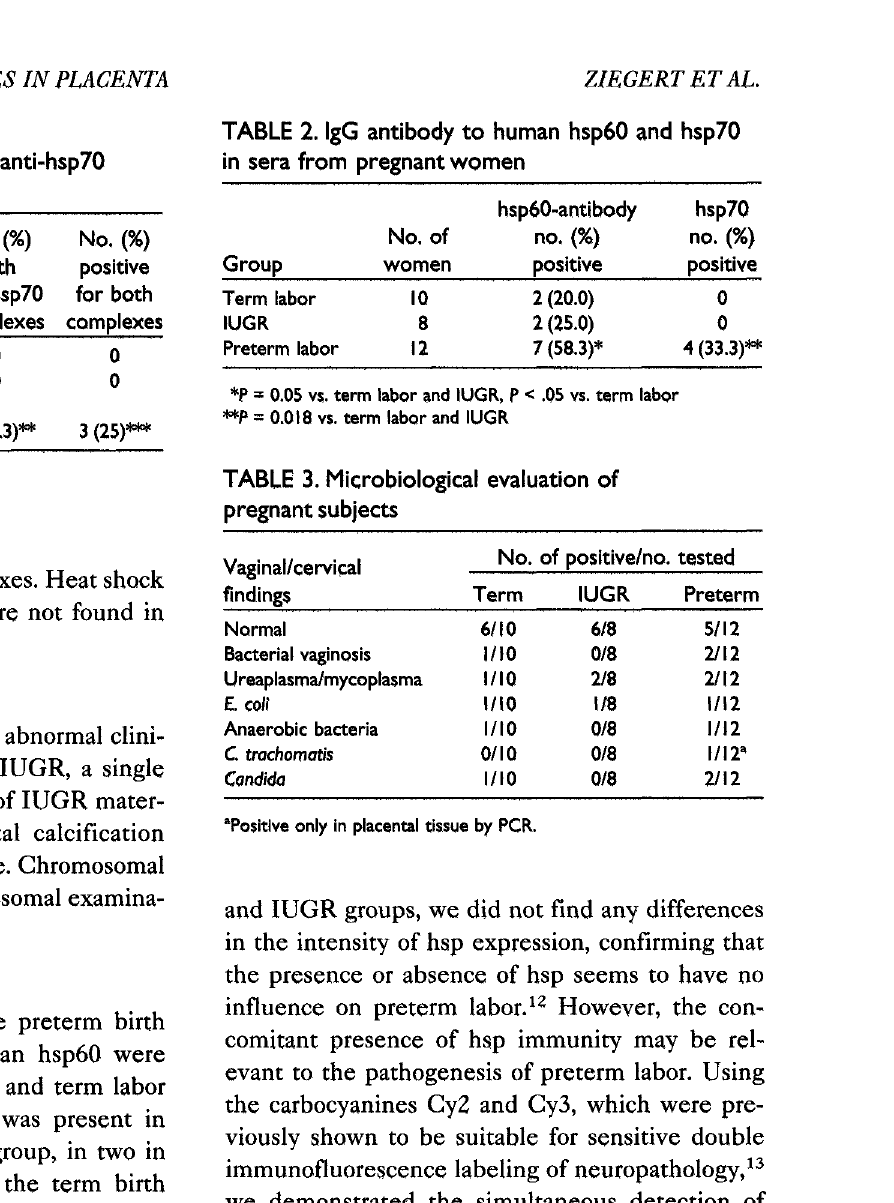
TABLE 2. IgG antibody to human hsp60 and hsp70 in sera from pregnant women hsp60-antibody